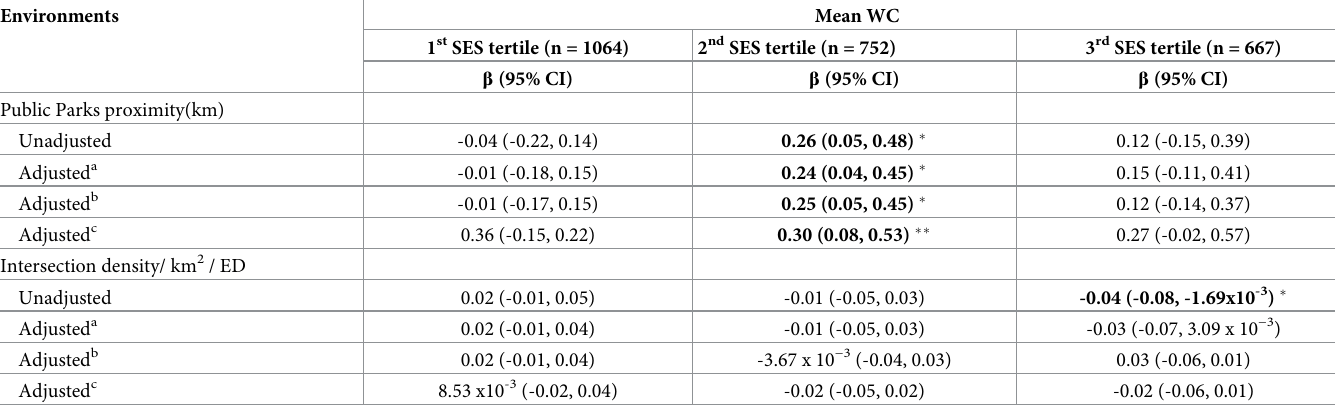
Table 6. SES-specific unadjusted and adjusted β coefficients (Confidence Intervals in brackets) for the association of public parks proximity and intersection den- sity/ km 2 / ED with mean Waist Circumference.